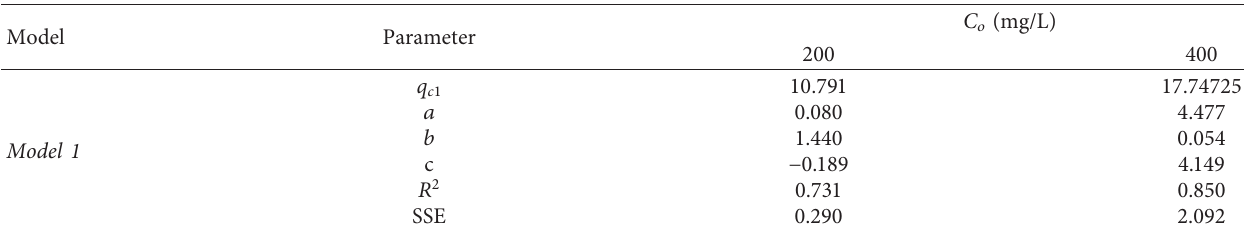
Table 5: Parameters of different numerical kinetic models for sorption kinetic data of nickel ions-CKD interaction.